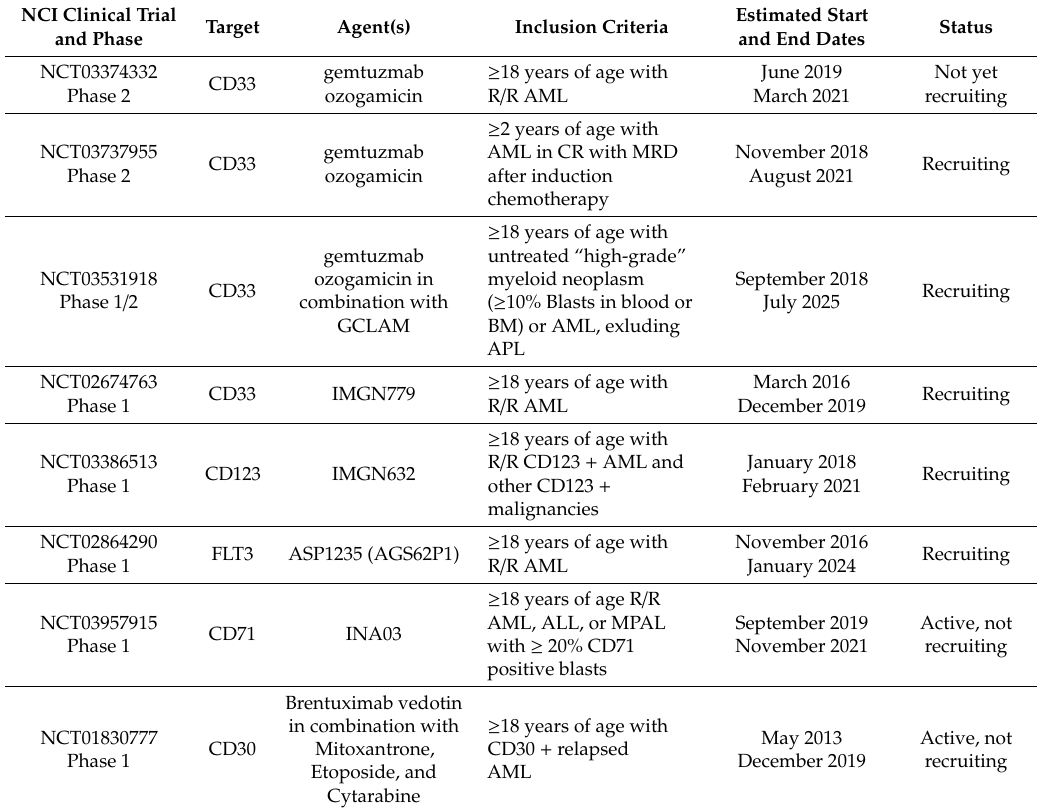
Table 2. Clinical trials of toxin-conjugated antibodies for